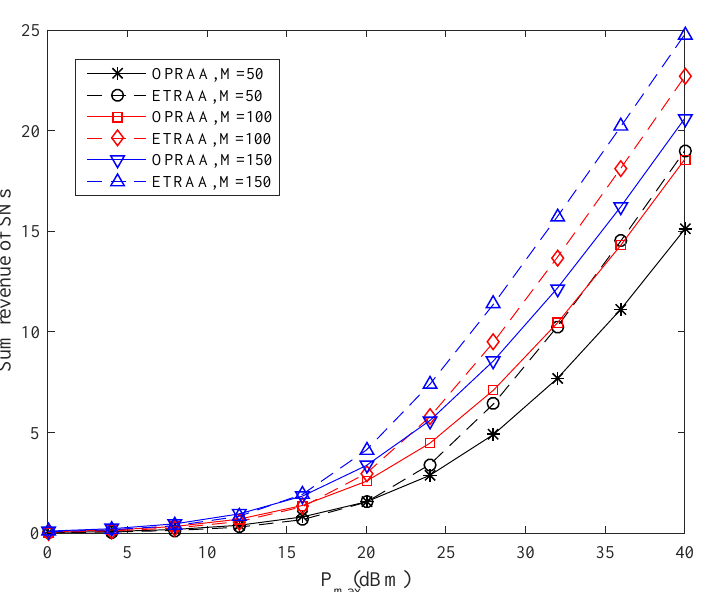
Figure 3. Revenue of PB.